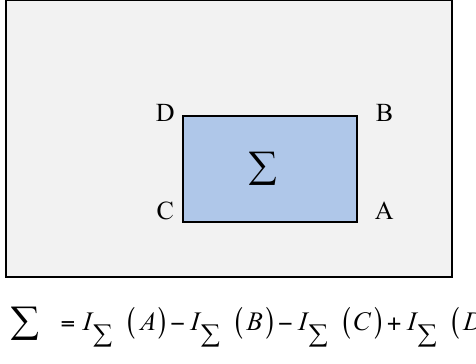
Figure 5. Functionality of the integral image.